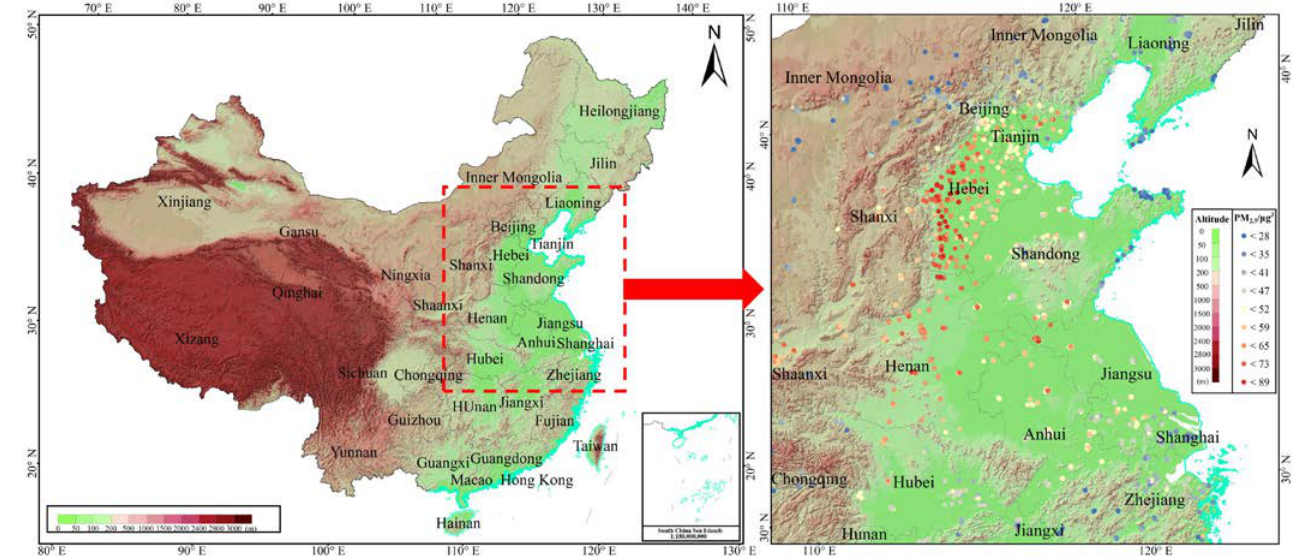
Figure 6. The geographical distribution and topographic features of North